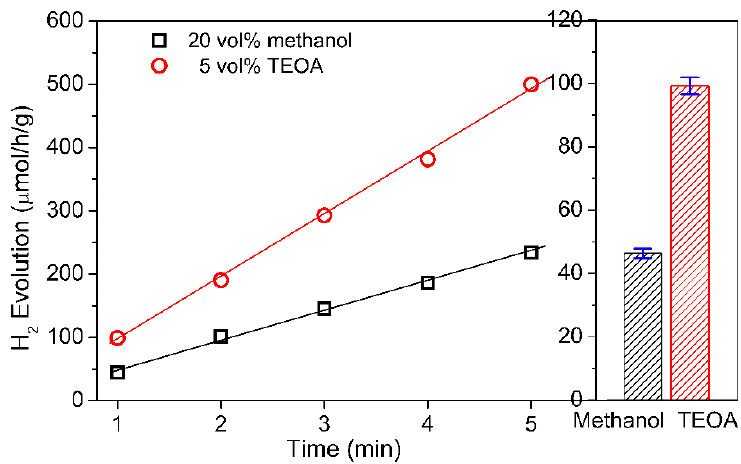
Figure 6. The H 2 evolution of SrWO 4 with different electron-donating sacrificial agents. Photocatalytic conditions: 50 mg SrWO 4 sample, 50 mL solution, 500 W Hg lamp.